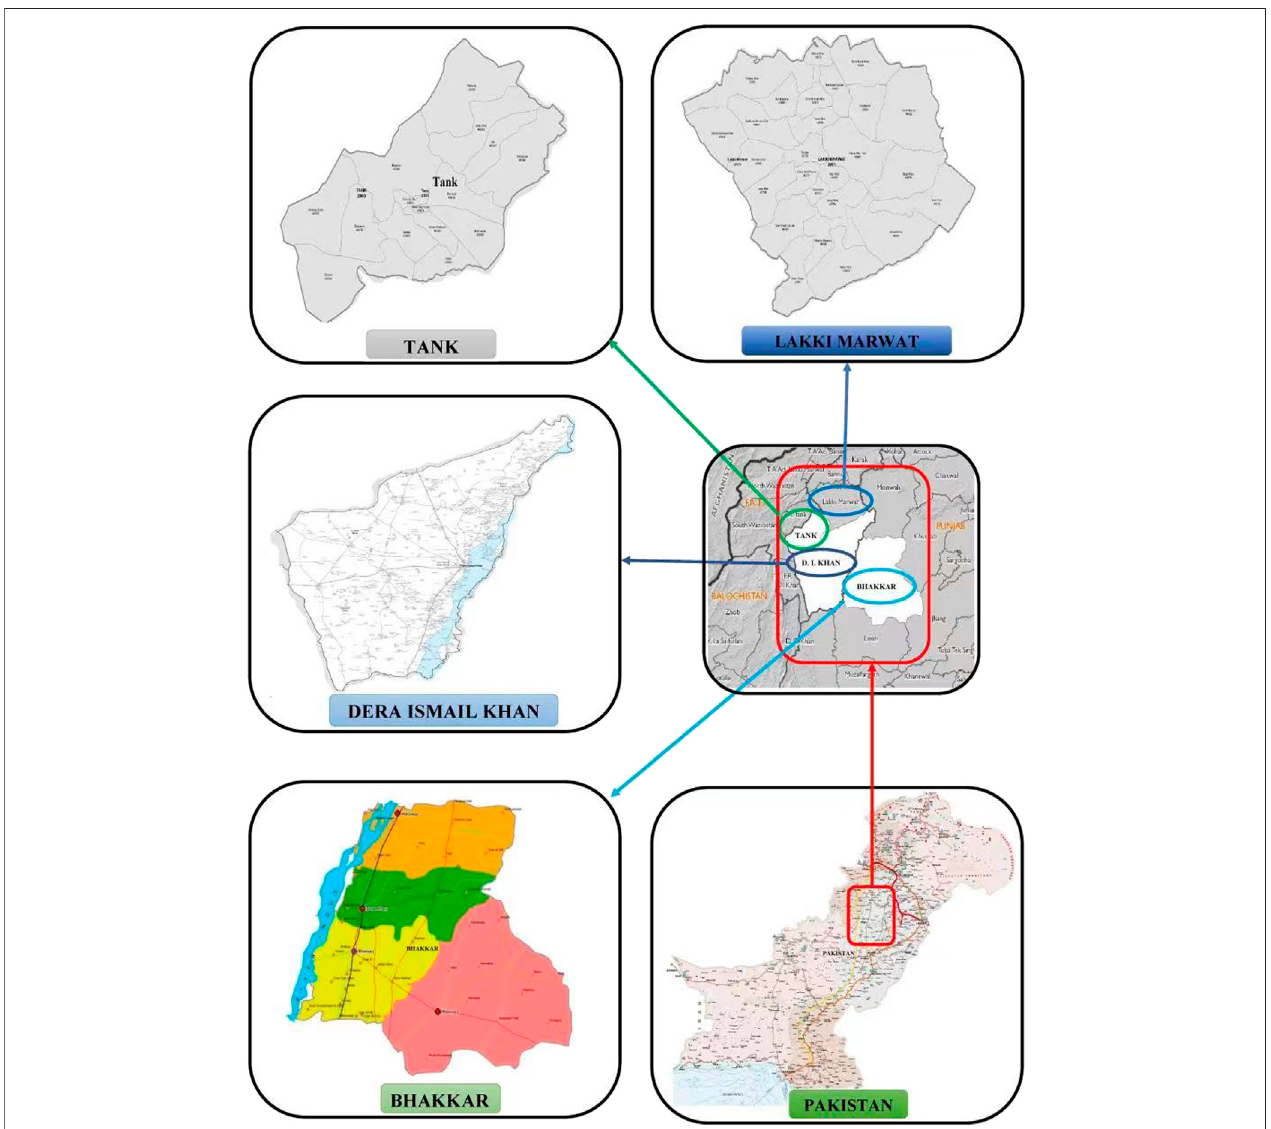
FIGURE 1 | Map of the target site (District Dera Ismail Khan, Bhakkar, Tank, Lakki Marwat), Pakistan. Source: (IVNM.net, 2021; LGCD, 2021; LGKP 2021).